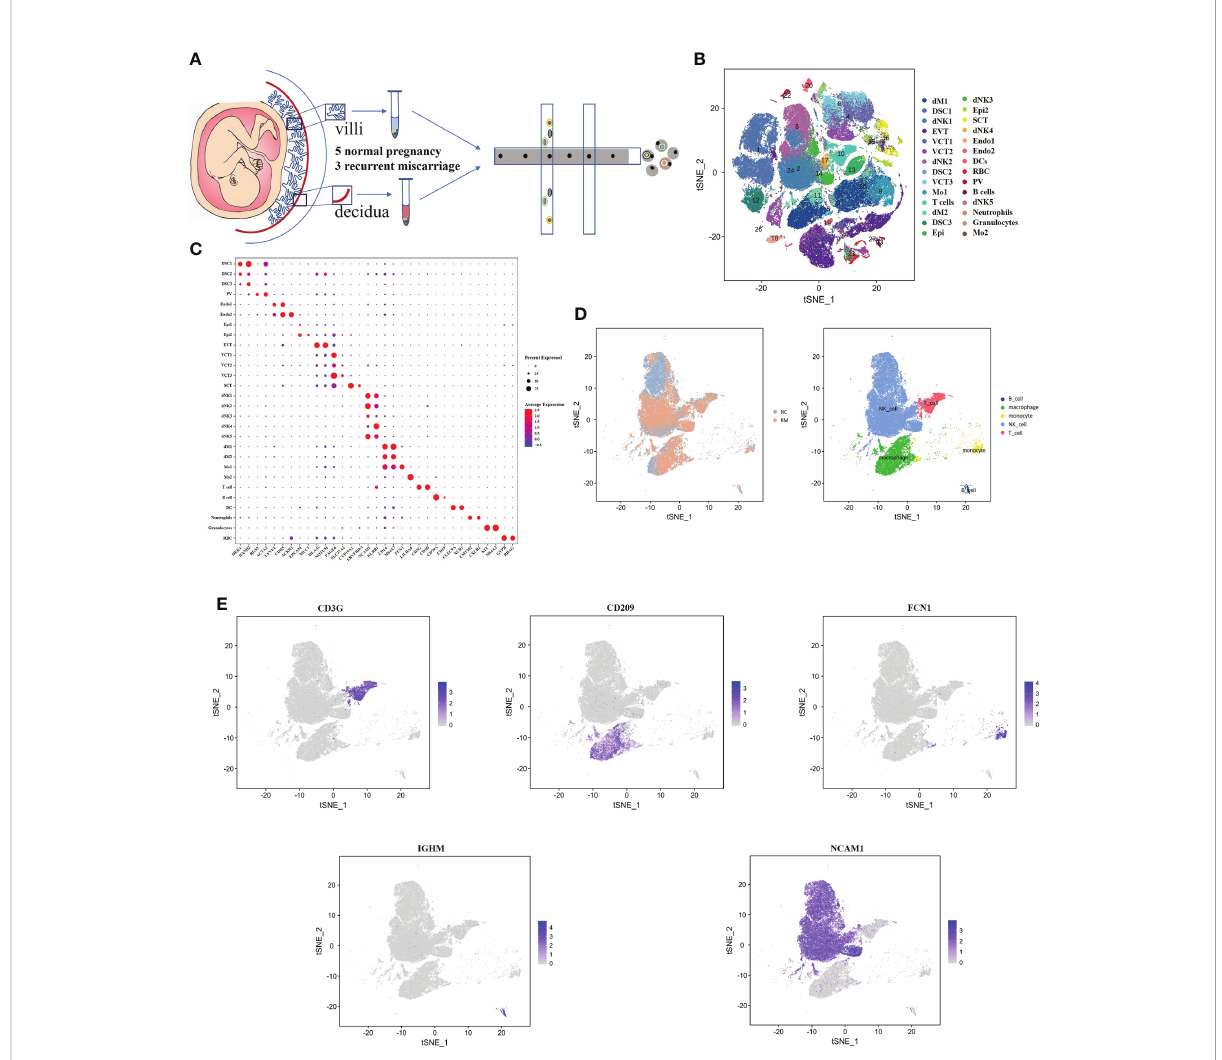
FIGURE 1 Single-cell RNA-sequencing analysis identi fi es maternal fetal interface marker genes (A) Flowchart depicting the overall design of the single-cell RNA-sequencing analysis. (B) t-SNE plot of 112528 cells from fi ve normal samples and three RM samples. dM, decidual macrophages; dNK, decidual NK cells; DSC, decidual stromal cells; EVT, extravillous trophoblast; VCT, villous cytotrophoblast; Mo, Monocytes; Endo, endothelial cells; SCT, syncytiotrophoblast; DC, dendritic cells; RBC, red blood cells; PV, perivascular cells; Epi, epithelial glandular cells; F, fi broblasts. (C) Dotplot map showing the expression of classical cell type ‐ speci fi c marker genes in each cluster. (D) t-SNE plot of the fi ve main immune cell types. (E) t-SNE plot showing the expression of the marker genes of the fi ve cell types noted